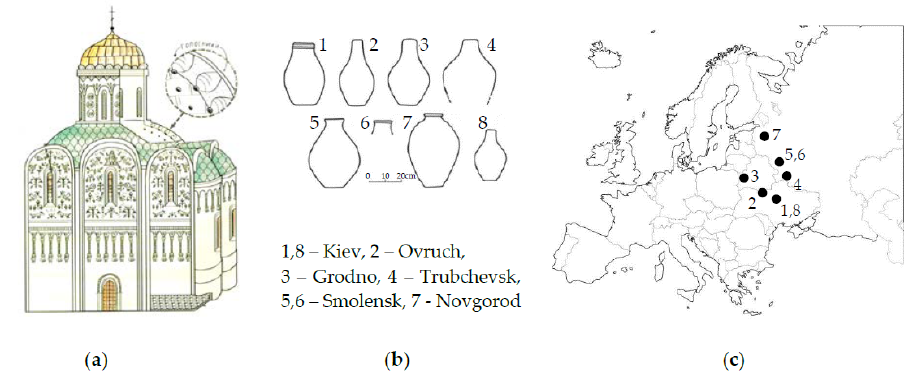
Figure 1. The acoustics vessels or “golosniki” in a Russian-style church ( a ), locally produced vessels ( b ) in the different construction centers of Russia till the beginning of 13th century ( c ).